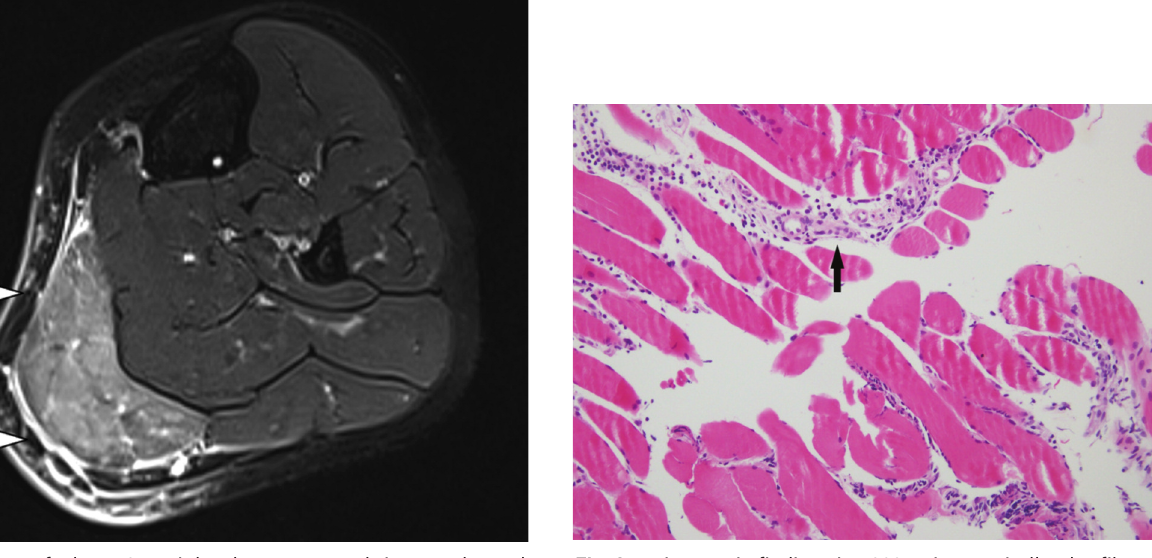
Left leg T2 weighted MRI coronal image showed Fig. 1: increased signal intensity on T2 weighted image and diffuse enhancement in gastrocnemius muscle (white arrow).